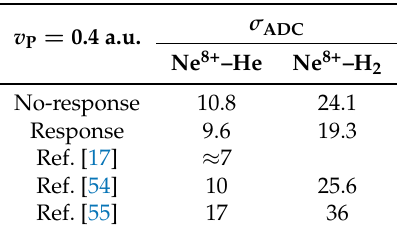
Table 1. Total ADC cross sections (in 10 − 16 cm 2 ) for Ne 8+ –He and Ne 8+ -H 2 collisions at v P = 0.4 a.u. Theory: present independent-electron model (IEM) two-center basis generator method (TC-BGM) in the no-response and response models; Harel and Jouin [17]. Experiment: Mack [54] (25% uncertainty); Bordenave-Montesquieu et al. [55] (35%